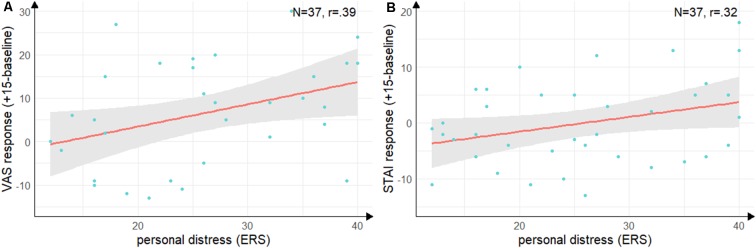
Correlations between personal distress and subjective stress response. (A) Correlation of the subscale personal distress of the ERS with difference scores on the visual analog scale from baseline (baseline) to peak (+15 min). (B) Correlation of the subscale personal distress with the difference scores on the state scale of the STAI from baseline (baseline) to directly after the TSST (+15 min). Note: shaded errors denote SEM.